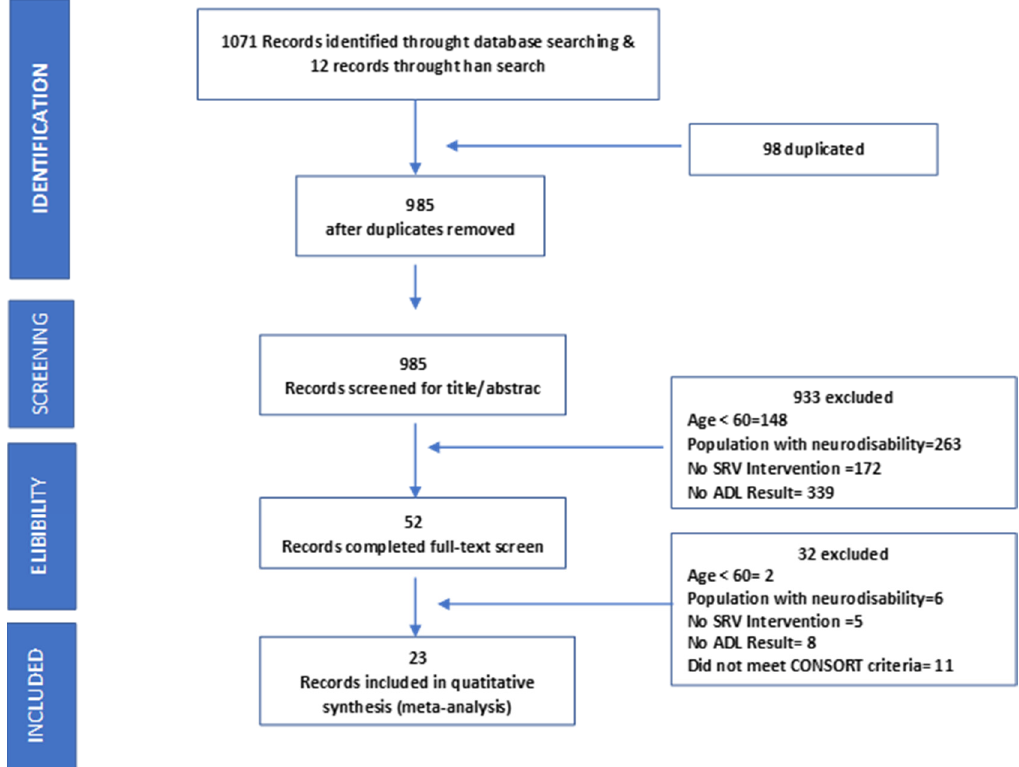
Figure 1. PRISMA flow diagram of search strategy and results.